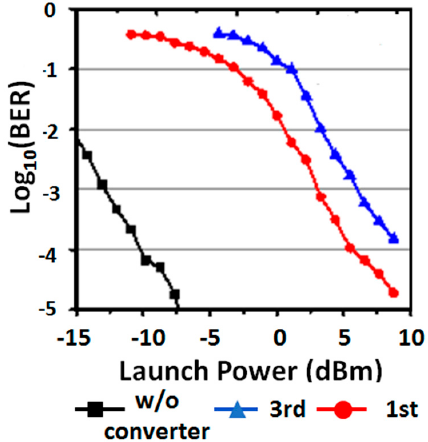
Figure 13. BERs versus optical launch power for the first and third converted optical components each obtained under its optimum operating conditions. A BER curve for the spectral conversion-free input optical signal is also plotted for comparison.